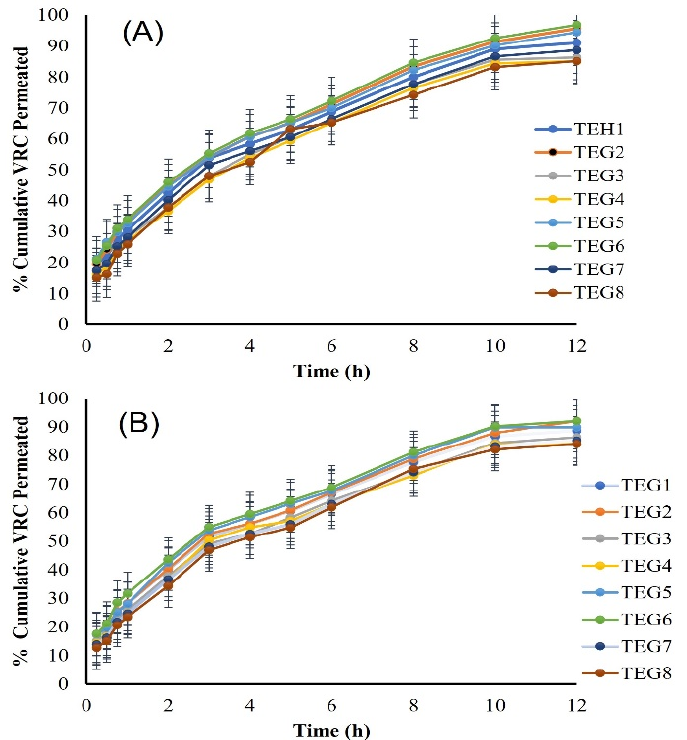
Figure 5. The ex vivo % cumulative voriconazole permeated ( A ) In vitro voriconazole permeated ( B ) of all formulations comparatively (Mean ± SD, n = 5). Table 3. The permeation flux (Jmax) at 12 h and the enhancement ratio (ER) of pure VRC and TEG6 formulation.